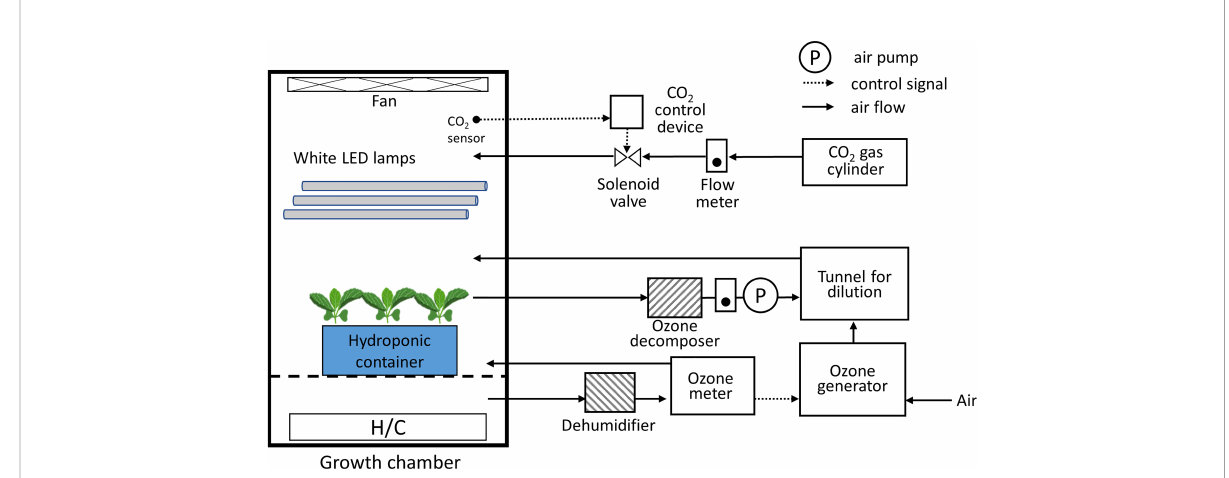
FIGURE 1 Schematic diagram of the growth chamber with an ozone concentration control equipment. The light period, photosynthetic photon fl ux density, CO 2 concentration, O 3 concentration, air temperature, and relative humidity in the chamber can be